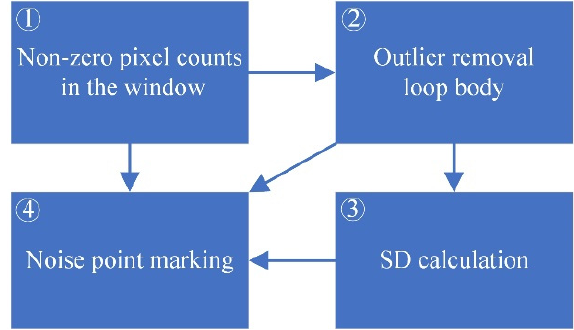
Figure 4. Improved Dixon test for depth image outlier detection. This algorithm combines the continuously draining outliers Dixon test and standard deviation (SD) calculation to perform macroscopic and microscopic identification of the center point. Algorithm 1 Outliers Detection